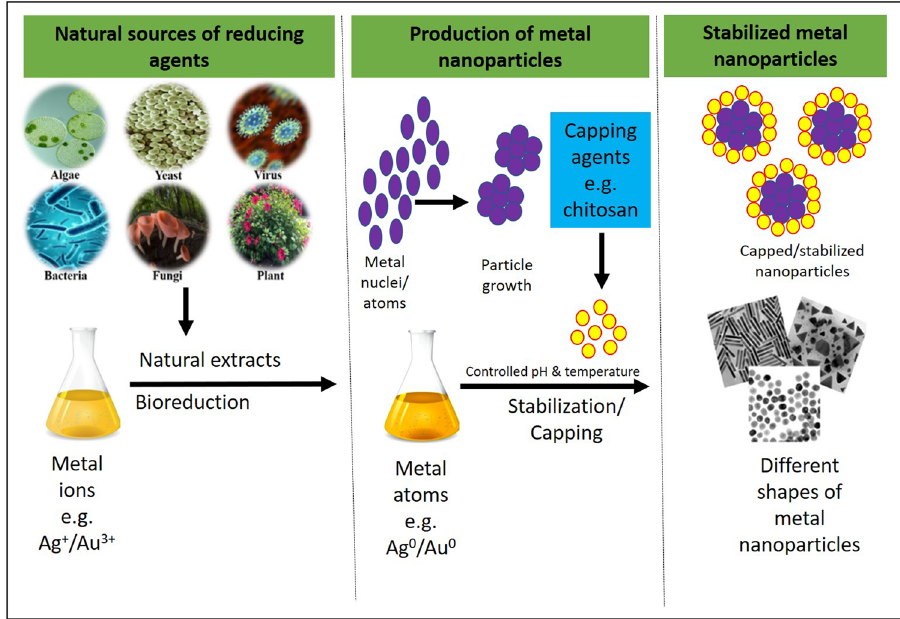
Figure 2: Mechanism of green synthesis ( biosynthesis ) of metal nanoparticles. Metal ions such as Ag + and Au 3 + are reduced into metal nuclei/atoms ( Ag 0 and Au 0 ) using extracts of natural sources such as plants and microorganisms. The metal nuclei/atoms are then accumulated or growing, and therefore, stabilizing/capping agents ( e.g. , chitosan ) are added to produce stabilized metal nanoparticles with small particle sizes. Various shapes of metal nanoparticles can be produced by controlling parameters during the synthesis such as concentration of metal ions and reducing agents as well as pH and